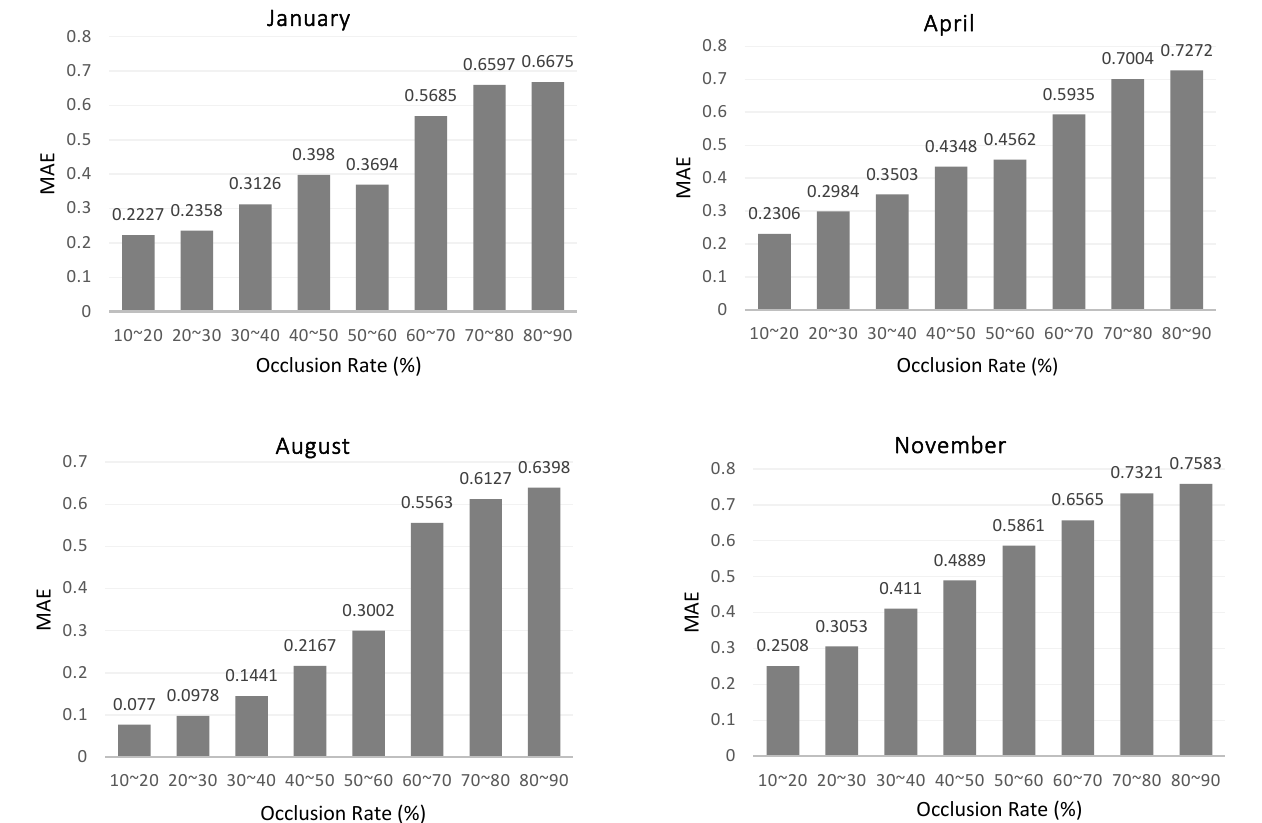
Figure 11. Reconstruction accuracy in MAE ( ◦ C) with respect to the eight different occlusion rates for four different months, namely January, April, August, and November.